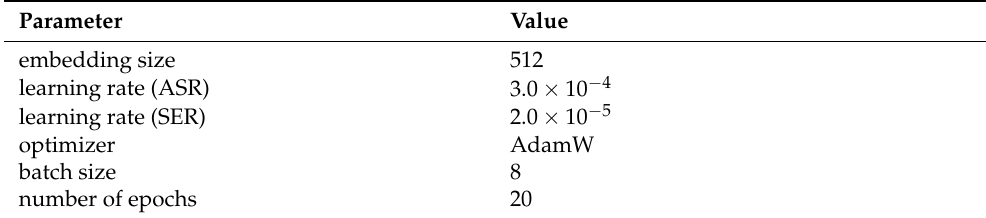
Table 1. Summary of training